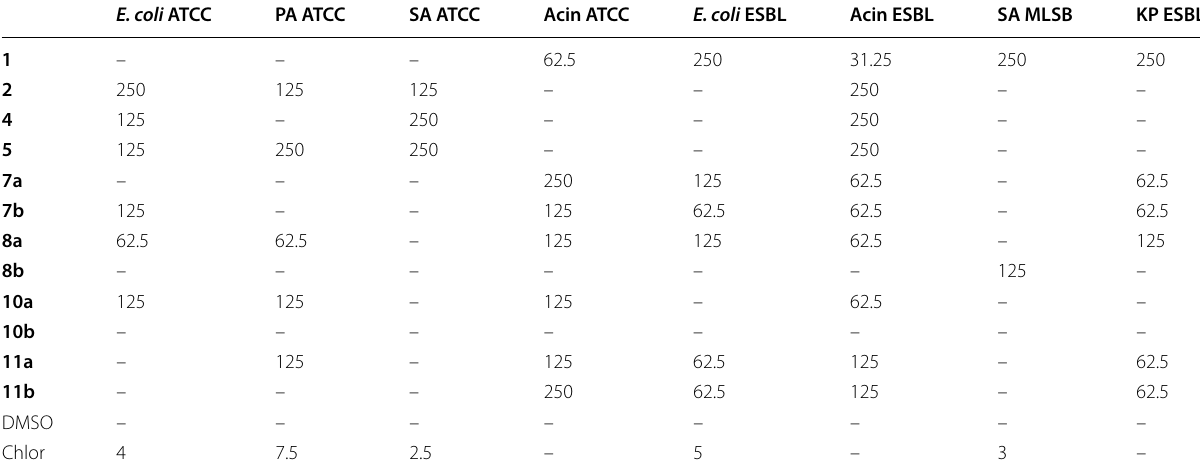
Chlor chloramphenicol (30 µg/ml), DMSO dimethylsulfoxide (1%)